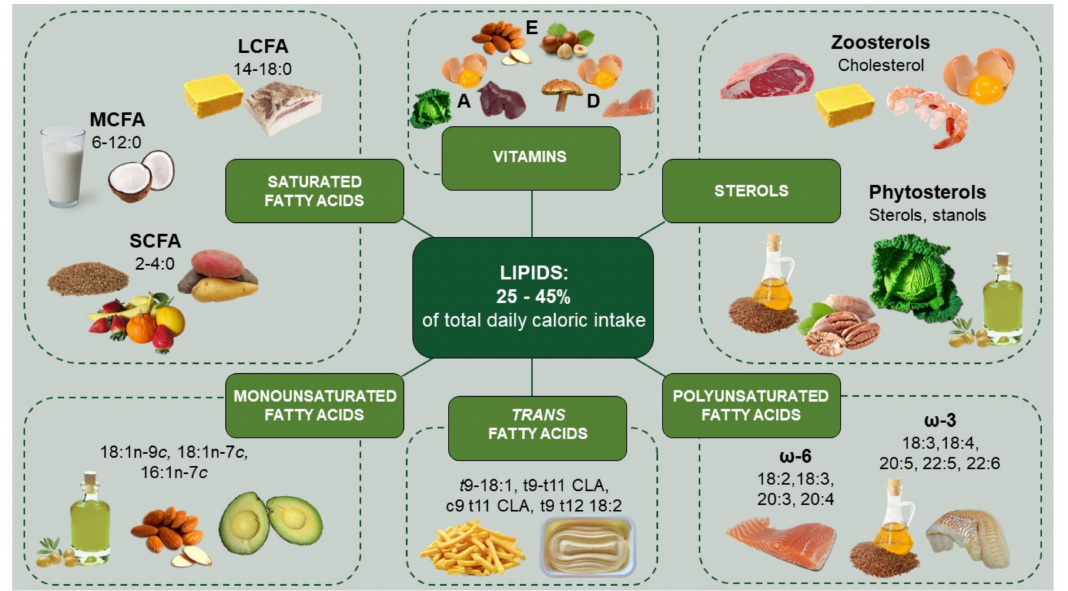
Figure 1. Main lipid classes and their dietary sources. Dietary lipids account for 25–45% of the total daily caloric intake and are classified into several subclasses based on their chemical structure. Saturated fatty acids are classified into SCFA, mainly obtained through the saccharolytic fermentation of undigested or partially digested fibers in proximal colon; MCFA, the main dietary source of which is represented by coconut oil and milk; and LCFA, found in large amounts in buttermilk, lard, and cocoa butter. MUFA are introduced into the diet through vegetable oils, mainly olive oil, sweet almond oil, avocado oil, canola oil, and others, whereas TFA are present in high amounts in partially hydrogenated vegetable oil and industrially processed food. The main dietary source of PUFA is represented by seeds and leaves of certain plants and cold-water fatty fish and fish oils. The main dietary source of cholesterol is represented by egg yolks, shrimp, meat, and buttermilk, whereas phytosterols such as sterols and stanols can be introduced through vegetable oils, grains and grain-derived products, and various nuts. Finally, dietary lipids can also be found in hydrophobic vitamins, such as vitamin A (bovine liver, egg yolk, spinach), vitamin D (egg yolk, cold water fatty fish and mushrooms), and vitamin E (hazelnut, olive oil, wheat germ oil). SCFA: short-chain fatty acids; MCFA: medium-chain fatty acids; LCFA: long-chain fatty acids; CLA: conjugated linoleic